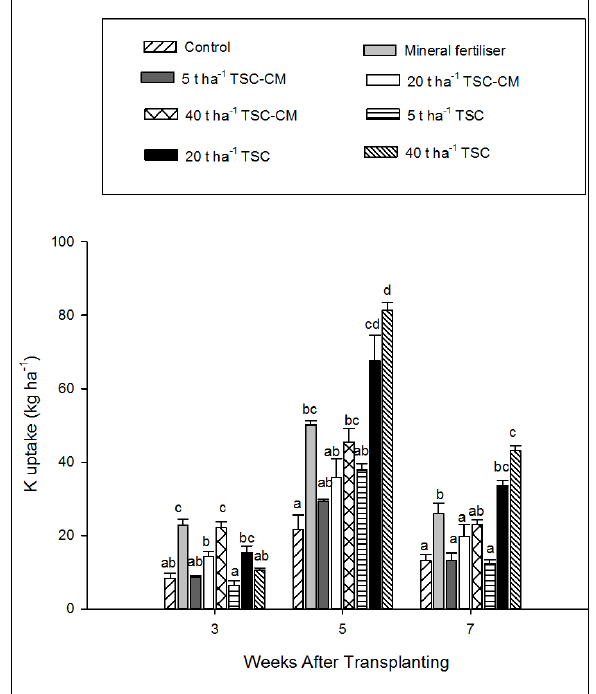
Figure 2: Oilseed rape ( Brassica napus L.) leaf tissue P uptake (mean±s.e.).